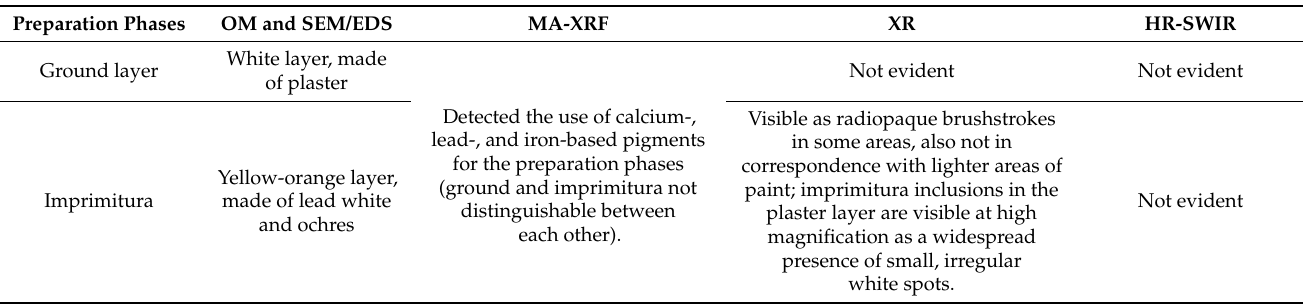
Table 2. Summary of the results on the preparation phases, from OM and SEM/EDS analyses on the cross section and MA-XRF, XR, and IRR imaging techniques on the whole